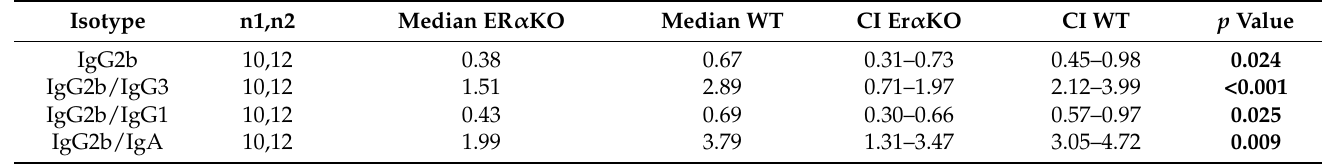
Figure 1. Improved ratios of IgG2b relative to other non-IgM isotypes in wildtype (WT) animals compared to ER α KO mice. Results from two sets of ER α KO and three sets of WT mice were combined for analysis. Each symbol represents a different mouse. Group medians are shown with 95% confidence intervals (CI). p values from Mann–Whitney tests are shown when p ≤ 0.1. Individual isotypes ( A – E ) and ratios ( F – H ) are shown. Table 1. Higher IgG2b in WT compared to ER α KO animals.